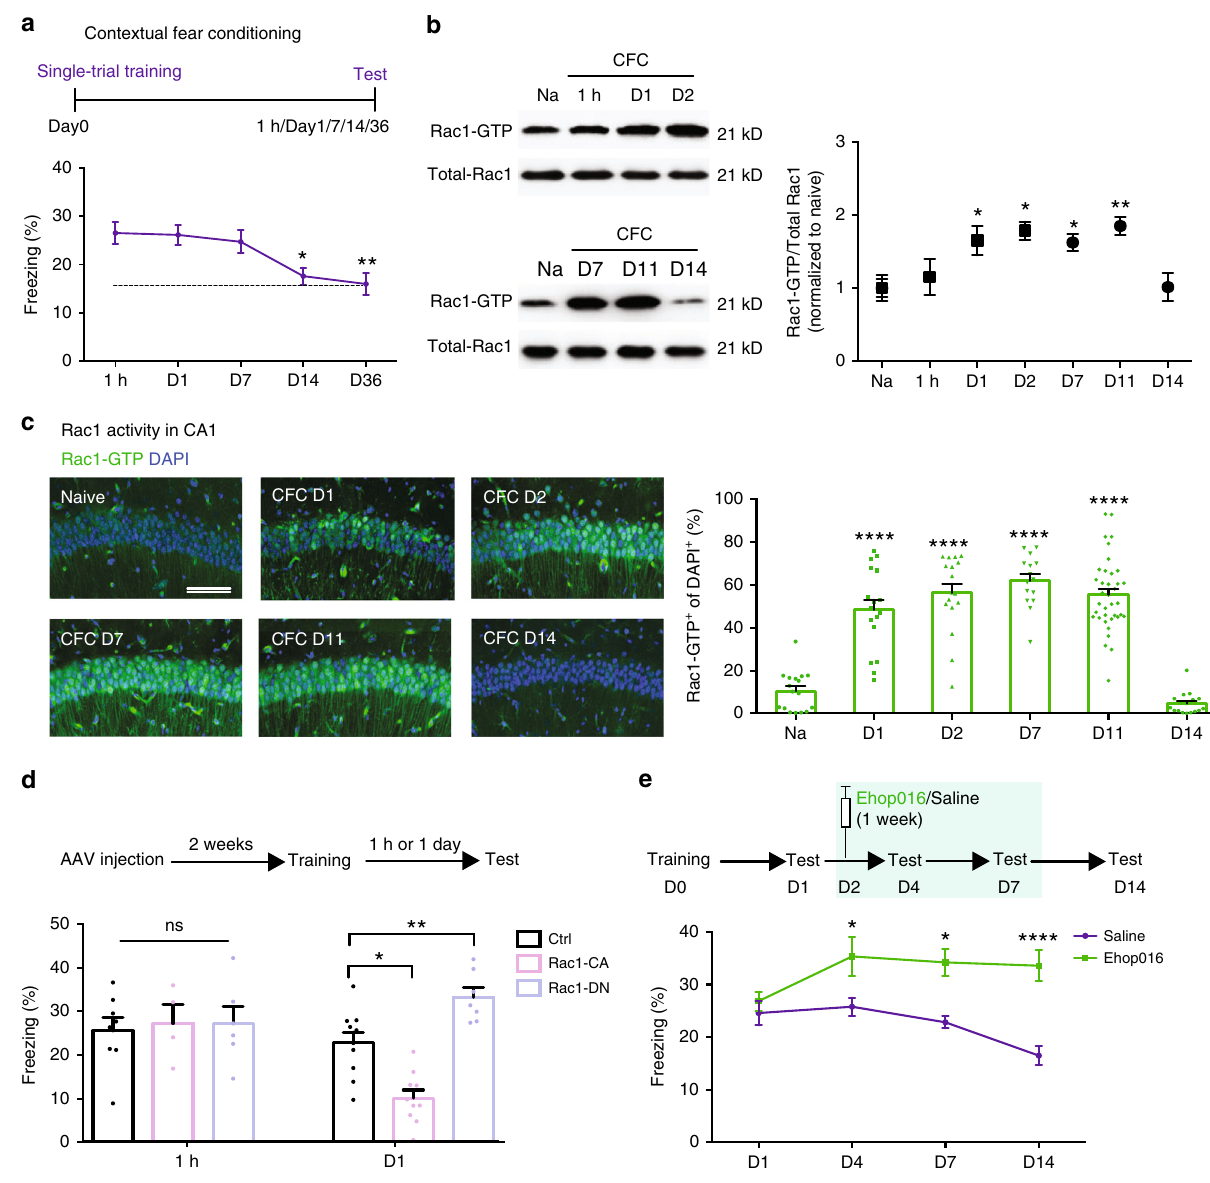
Fig. 1 Inhibition of learning-induced Rac1 activity causes memory enhancement. a Behavioral schedule (top) for contextual fear conditioning (CFC)-induced memory retention curve (D, day) in wild-type (WT) mice (bottom). WT mice were trained using one-shock CFC and then separate group mice were tested for memory retention at various periods (1 h, day 1, day 7, day 14, or day 36). * P < 0.05 and ** P < 0.01 (from one-way ANOVA); n = 41, 28, 17, 22, and 21 mice. b Representative image of western blottings (left) and data (right) showing total Rac1 levels and Rac1-GTP in hippocampal extracts from naive (Na) and trained (one shock) at various retention intervals (1 h, day 1, day 2, day 7, day 11, or day 14). * P < 0.05 and ** P < 0.01 (from one-way ANOVA); n = 12, 7, 7, 3, 4, 4, and 4 mice. c Representative immunostaining of Rac1-GTP (left) and data (right) showing percentages of Rac1-GTP + cells in the hippocampal CA1 region of Na mice and CFC mice at various periods (day 1, day 2, day 7, day 11, or day 14). Coronal sections of the hippocampal CA1 region of Na